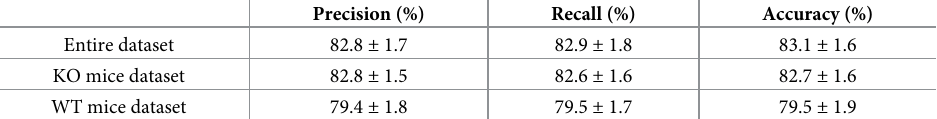
Table 3. Test set classification results of CNN architecture considering the entire dataset and the two genotype- based datasets, evaluated in terms of precision, recall and accuracy values using 9 classes of calls.